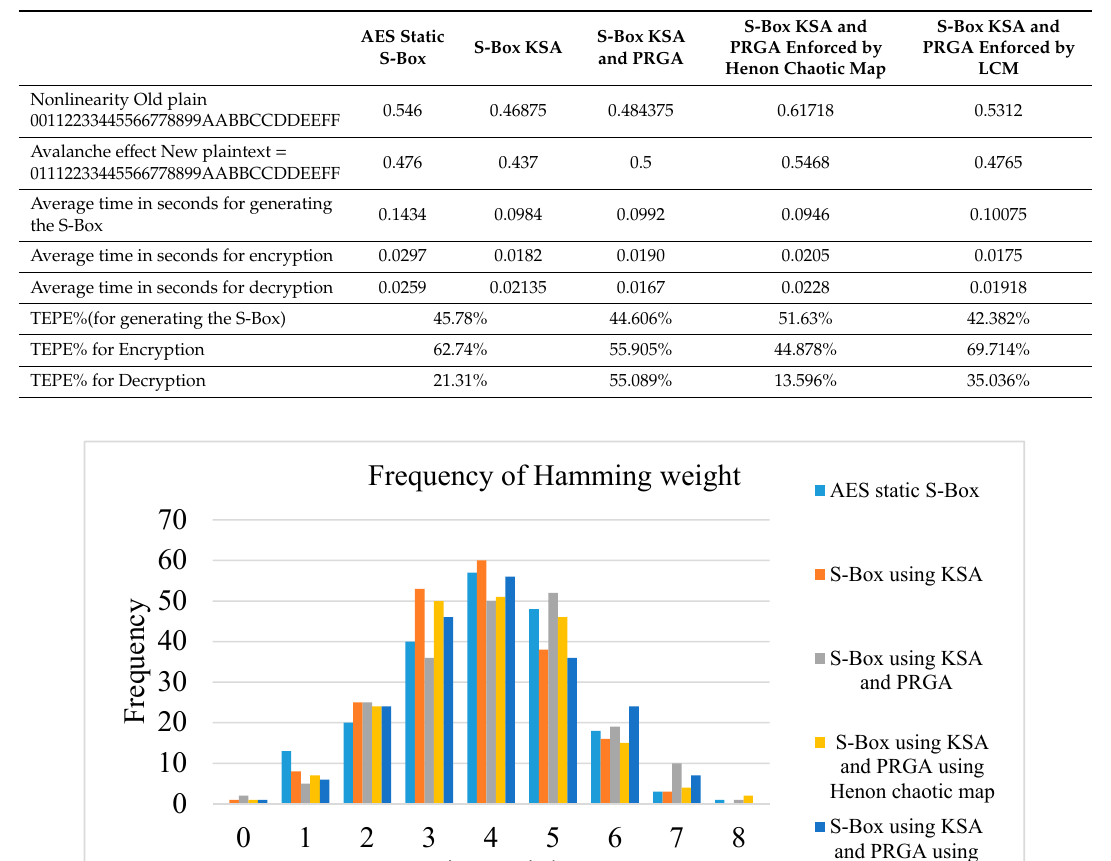
Figure 10. Analysis of Hamming weights according to the bit position for the five S-Boxes using the key “0123456789ABCDEF “. Table 7. Results with the key “F9E8D7C6B5A40123”.